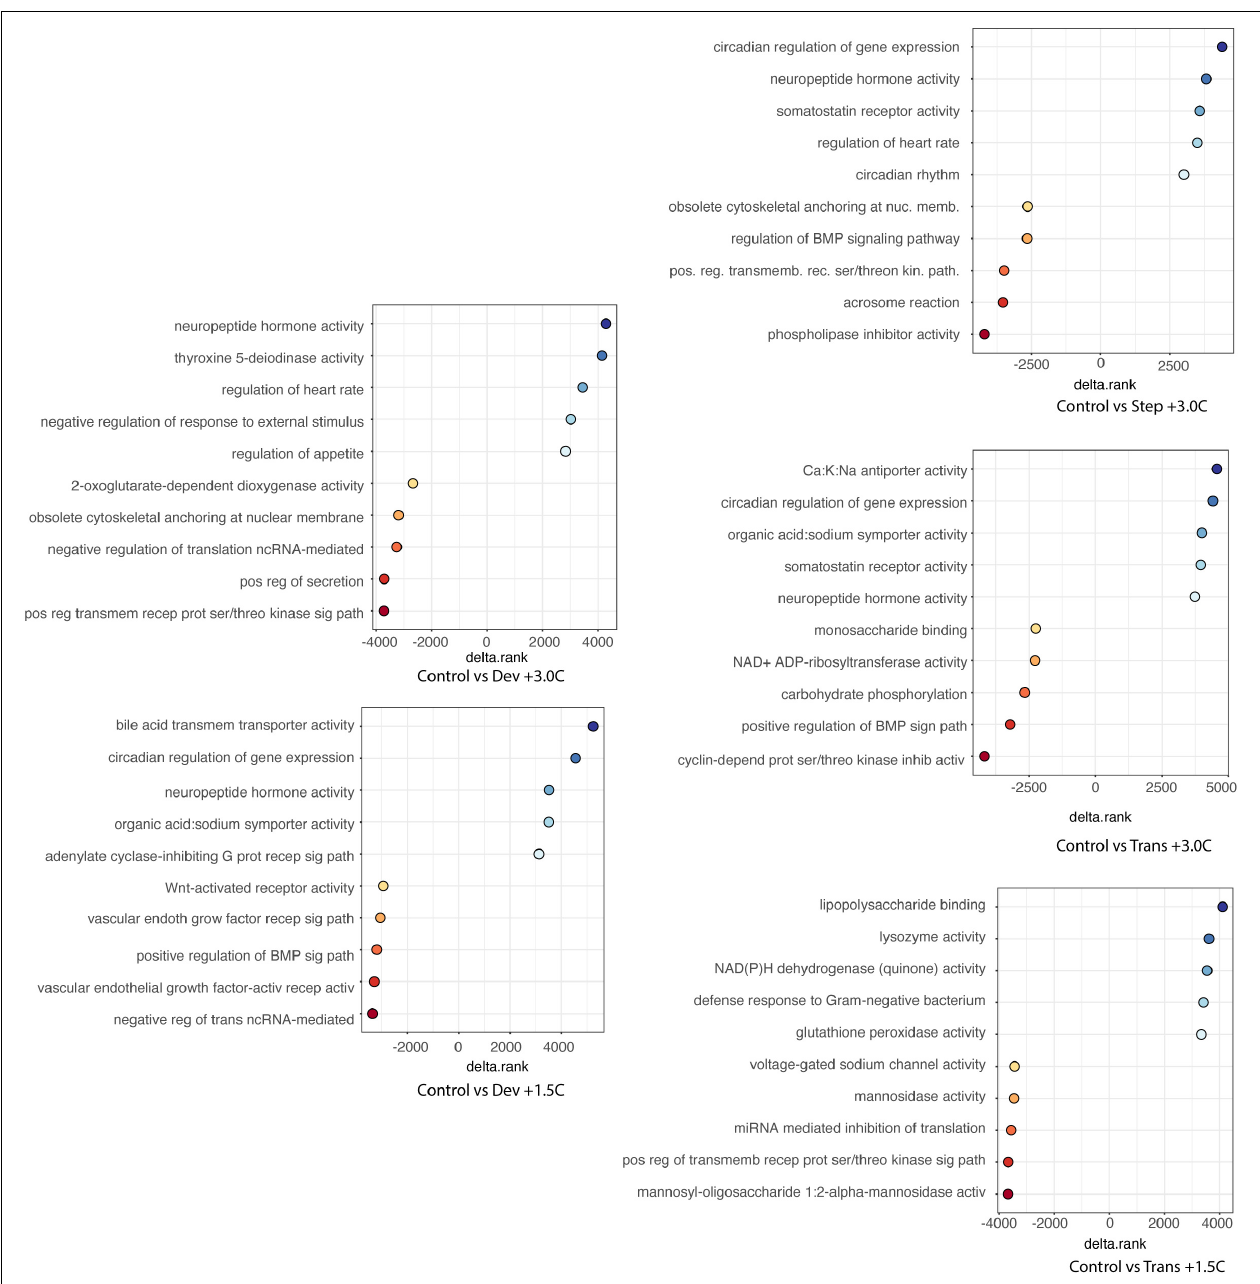
FIGURE 3 | Top five up- or downregulated GO categories for pairwise comparisons of the F2 compared to Control. The X -axis represents the Delta-rank, which is a measure of the intensity by which a category is activated or suppressed in a particular comparison. The Y -axis represents the specific categories.